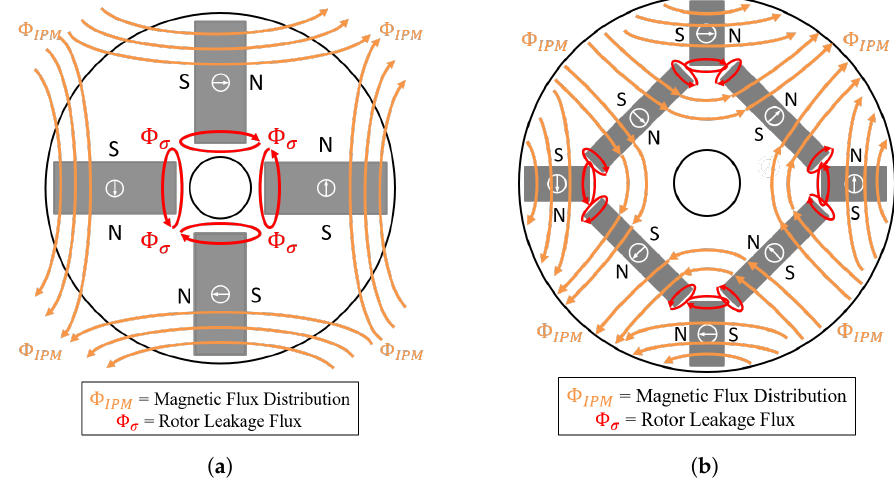
Figure 5. Representation of magnetic flux paths of: ( a ) IPM rotor with radial permanent-magnet; ( b ) proposed IPM